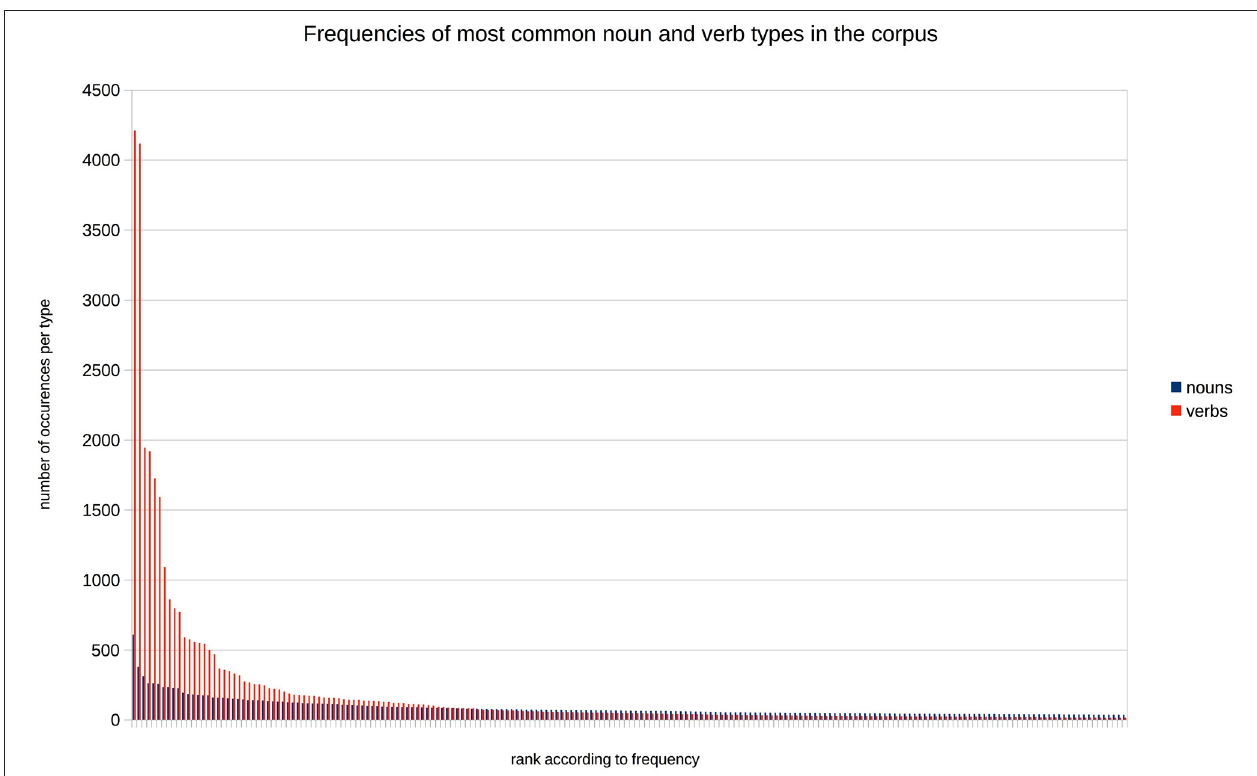
FIGURE 2 | The number of occurrences of the 200 most frequent noun and verb types in the corpus, ranked by